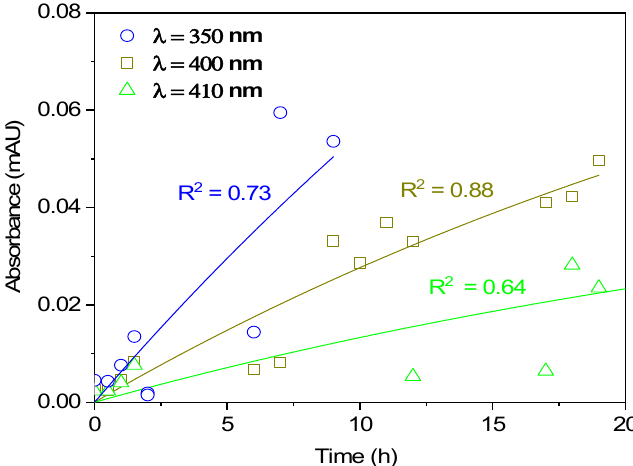
Figure 4. Brown carbon (BrC) formation in 0.1 mM 3-methylcatechol and 0.1 mM NaNO 2 under sunlight conditions. Experimentally measured (symbols) and modeled absorbance (solid lines) at different wavelengths representative of BrC.